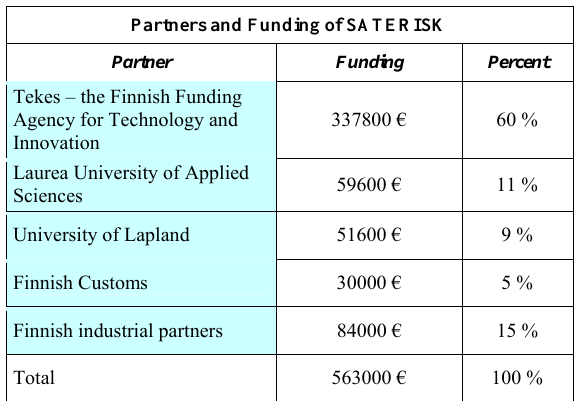
TABLE II. P ARTNERS AND B UDGET OF SATERISK